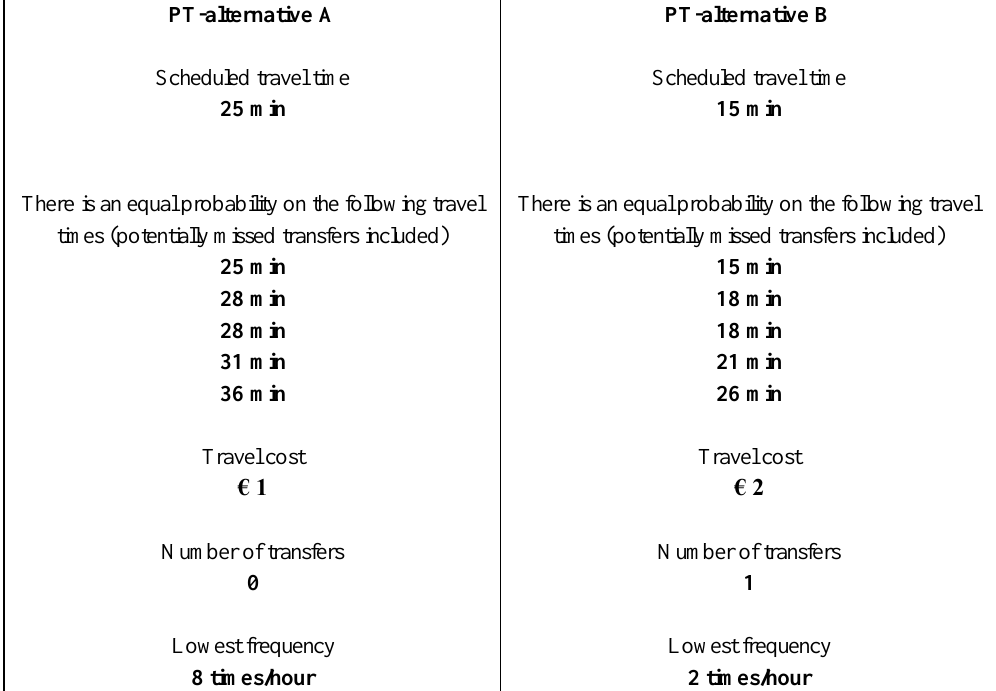
Figure 2. Example of a choice